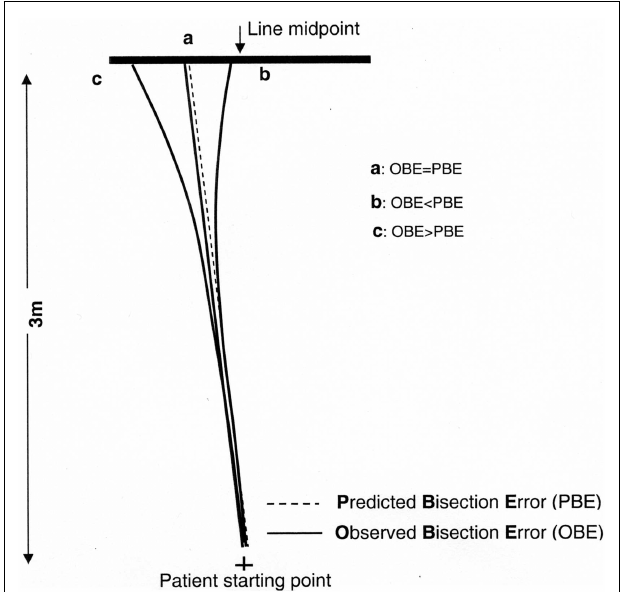
FIGURE 4 | Graphic representation of different possible walking trajectories of the patient and observed (OBE) or predicted (PBE) bisection errors: if OBE = PBE (a) the trajectory is rectilinear and space remapping is absent .The far space representation (more compromised) activated at the beginning of walking is maintained throughout the entire path, resulting in a leftward error; if OBE < PBE (b) the trajectory is curvilinear because the patient corrects the trajectory while approaching the target remapping the initial far space representation (more compromised) into a near space representation (less compromised).This results in an error reduction relative to (a); if OBE > PBE (c) it is indicative of a tendency to veer in the direction of neglect during walking not related to space remapping but consequent to an error in heading control resulting from the patient attempt to correct the ipsilesional deviation of the subjective midline which is typically associated to neglect (Huitema et al.,